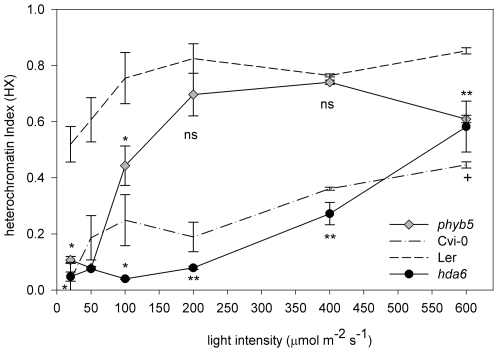
PHYTOCHROME-B and HISTONE DEACETYLASE-6 are positive regulators of light-dependent chromatin compaction.Heterochromatin index of phyB5 (gray diamonds), hda6 sil1/not1 (black circles), Cvi-0 (dash-dotted line), and Ler (dashed line) grown in different light intensities. n≥2. *** p<0.001; ** p<0.01; * p<0.05; + p<0.1; ns = non significant; significance value compared to Ler. Error bars represent SE in al cases.